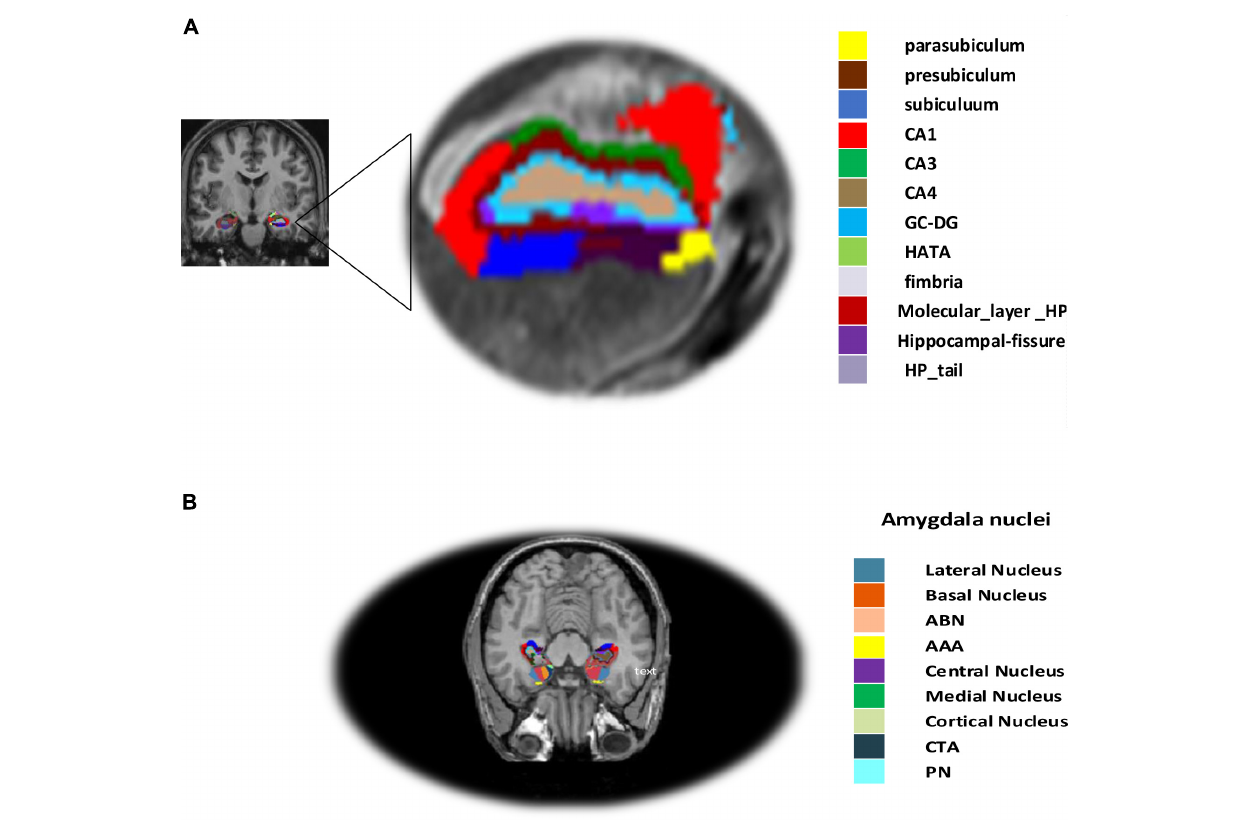
FIGURE 2 | (A) Structural MRI (sMRI) of hippocampal subfield and (B) amygdala nuclei